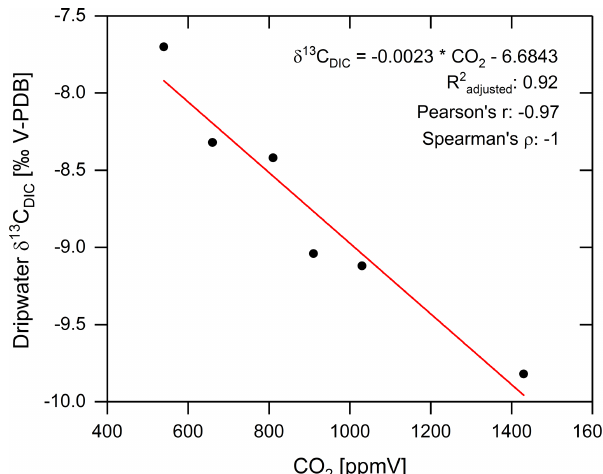
Figure 8. Relationship between cave air CO 2 concentrations and dripwater δ 13 C DIC quantified based on the six maxima/minima recorded during the case study (black circles). The relationship can be fitted very well with a linear regression (red